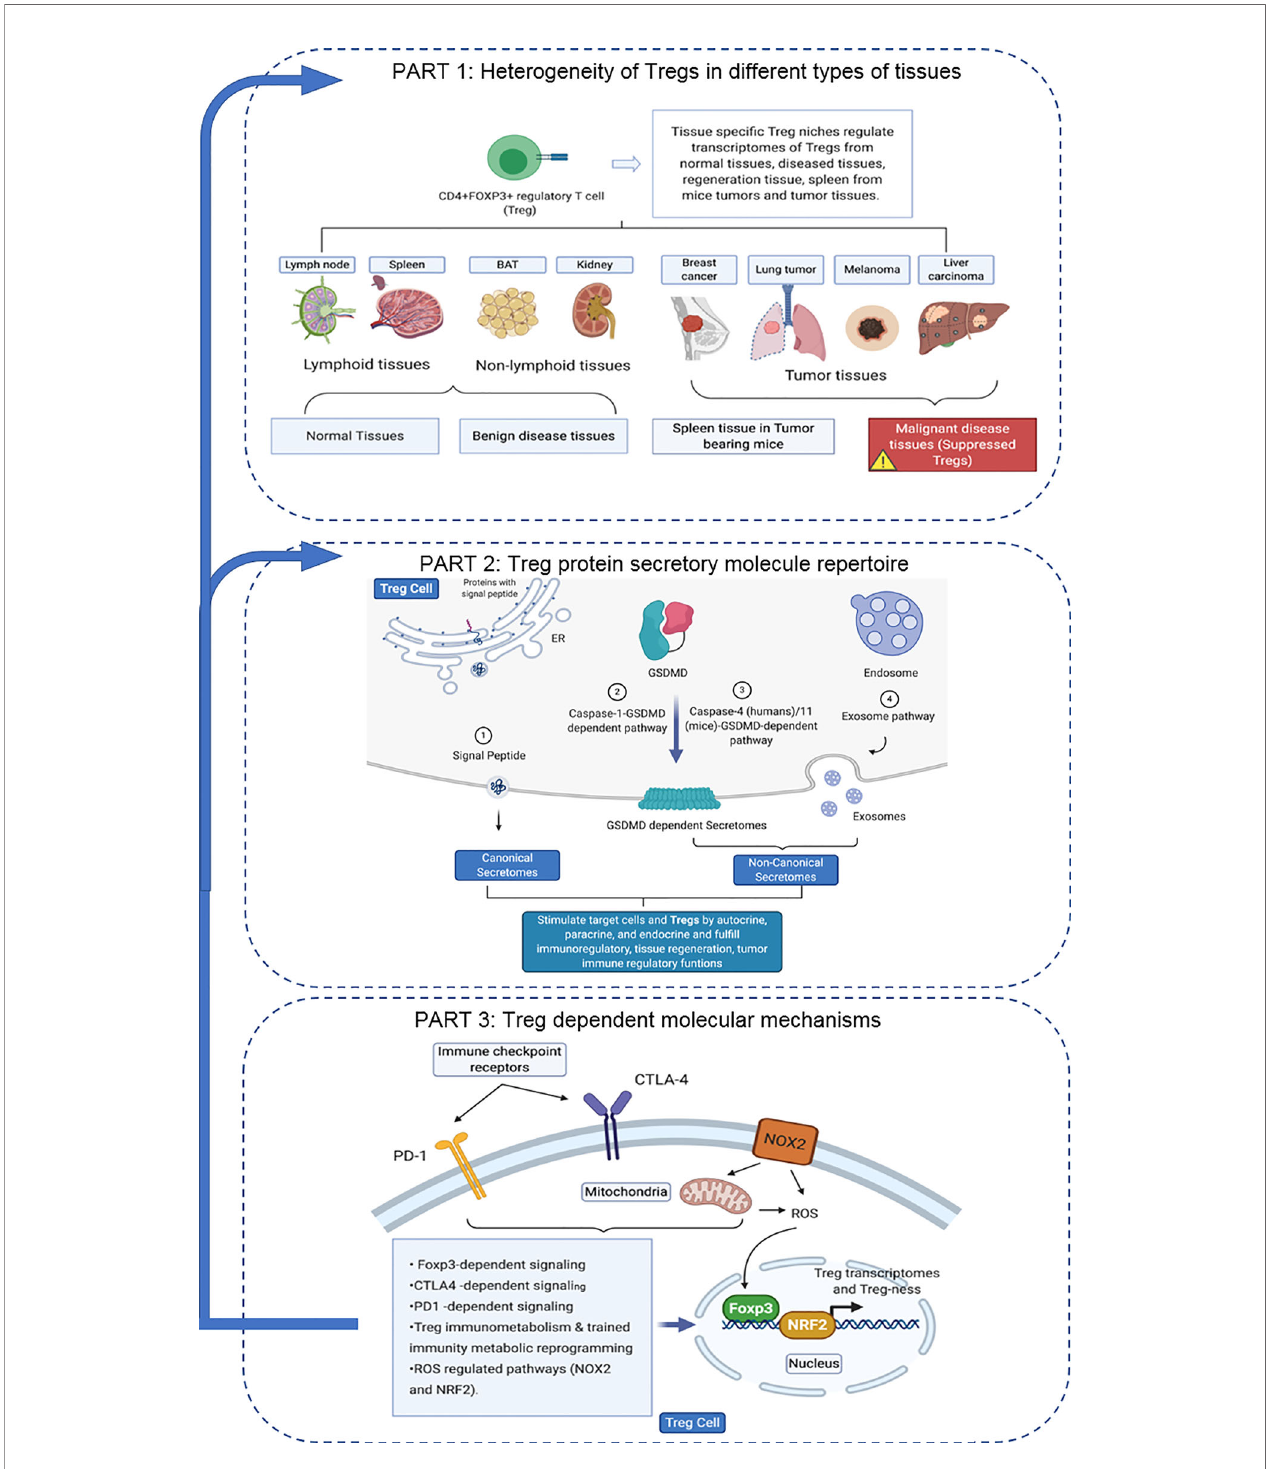
FIGURE 13 | Canonical secretome, caspase-1-, caspase-4/11-gasdermin D non-canonical secretomes and exosomes may contribute to Treg heterogeneity, immunosuppression, tissue repair and weaken anti-tumor immune responses via ROS pathways, Foxp3, PD-1, CTLA-4, immunometabolism and trained immunity metabolic reprogramming. BAT, Brown adipose tissue; GSDMD, Gasdermin D; ER, Endoplasmic reticulum; PD-1, Programmed cell death protein 1; CTLA4, Cytotoxic T-lymphocyte-associated protein 4; ROS, Reactive oxygen species; Nox2, Nicotinamide adenine dinucleotide phosphate (NADPH) oxidase 2; Nrf2, The nuclear factor erythroid 2 (NFE2)-related factor 2; FOXP3, Forkhead box